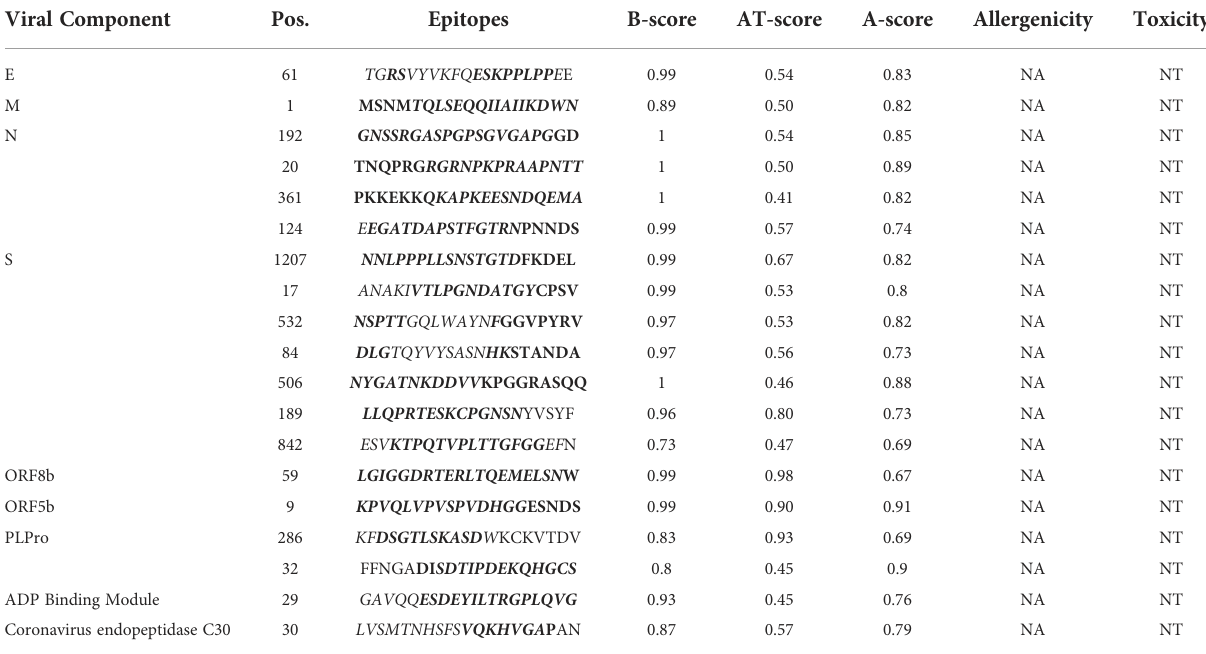
TABLE 2 Selection of B-cell epitopes. Twenty amino acid-long B-cell epitopes were predicted with BCPREDS and validated with BepiPred and ABCPred servers. Viral Component